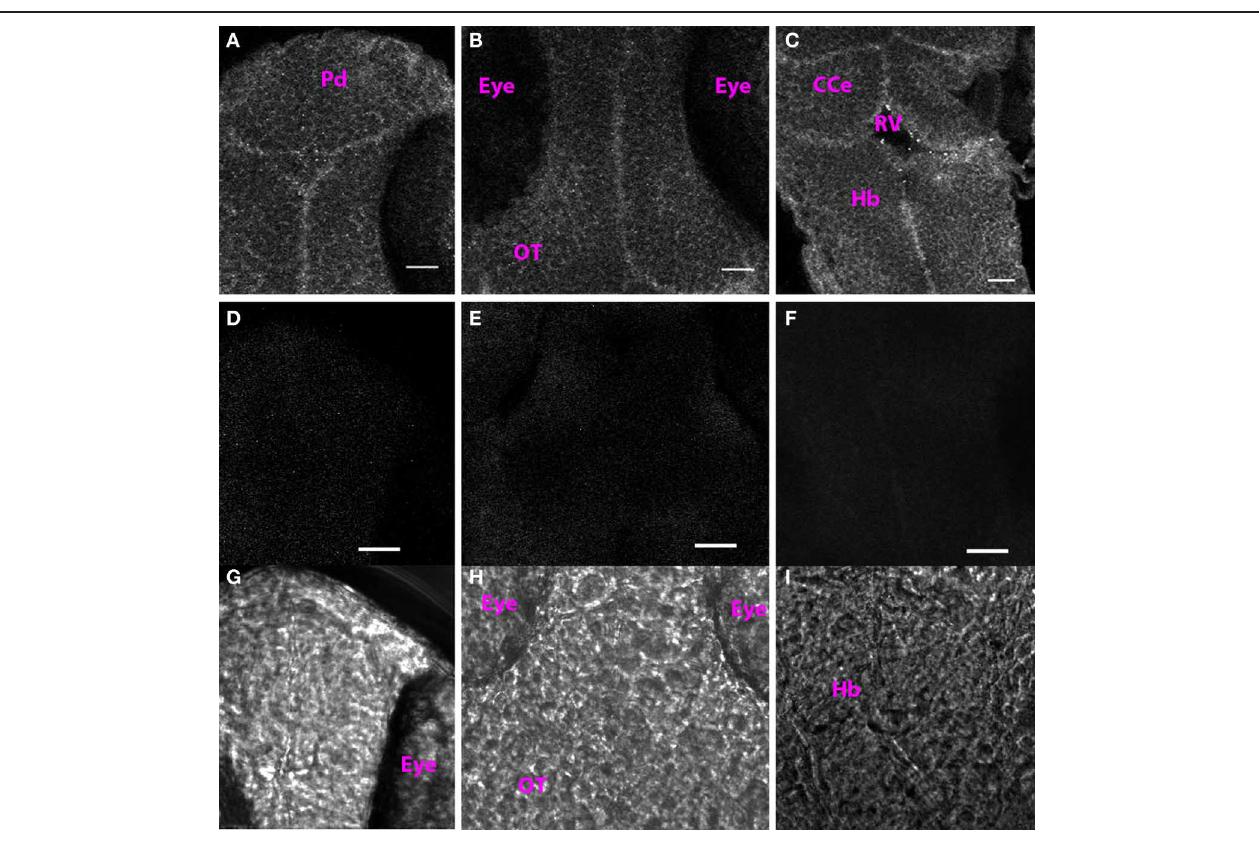
dorsoventral position. (D–F) Single optical sections from control larvae in which the primary antibody was not included in the incubation mixture. (D) Dorsal telencephalon. (E) Optic tectum. (F) Hindbrain. (G–I) Transmitted light images of the regions imaged in (D–F) . Scale bar for all panels: 20 µ